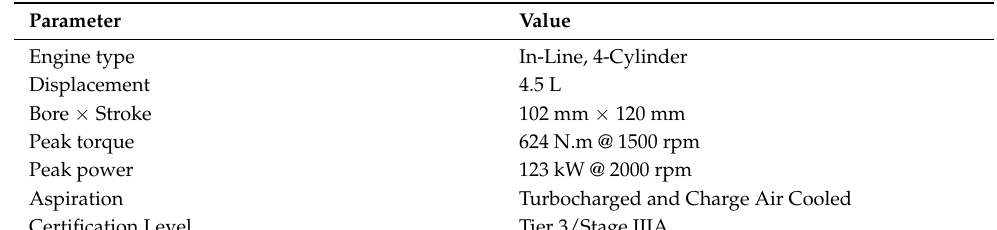
Table 1. Engine specifications.